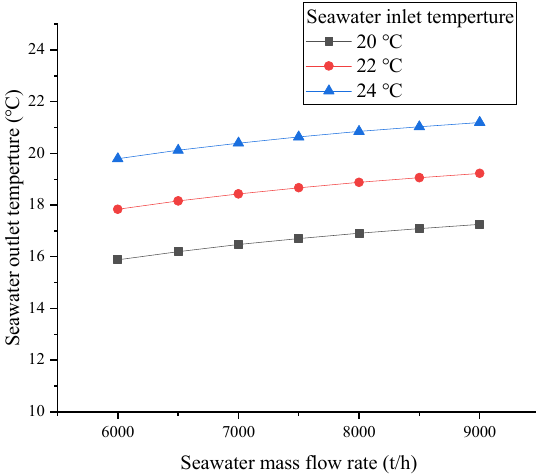
Figure 14. Effect of seawater flow rate on the IFV seawater outlet temperature. By law, the temperature difference between the seawater inlet and outlet needs to be controlled to 5 °C or lower. A lower limit of seawater flow exists to ensure that the